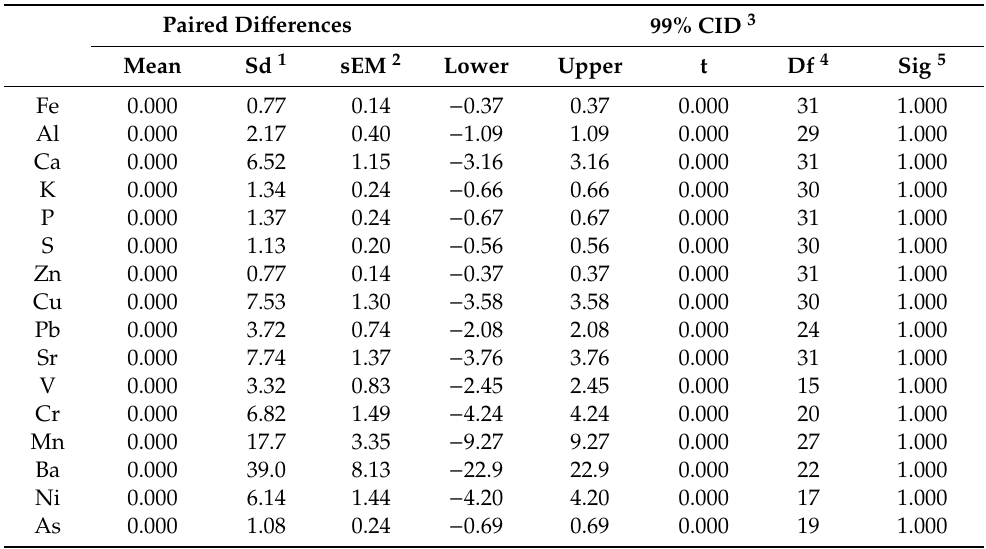
Table 5. Paired samples t-test between actual and predicted aqua regia -extractable elemental contents using the multiple regression